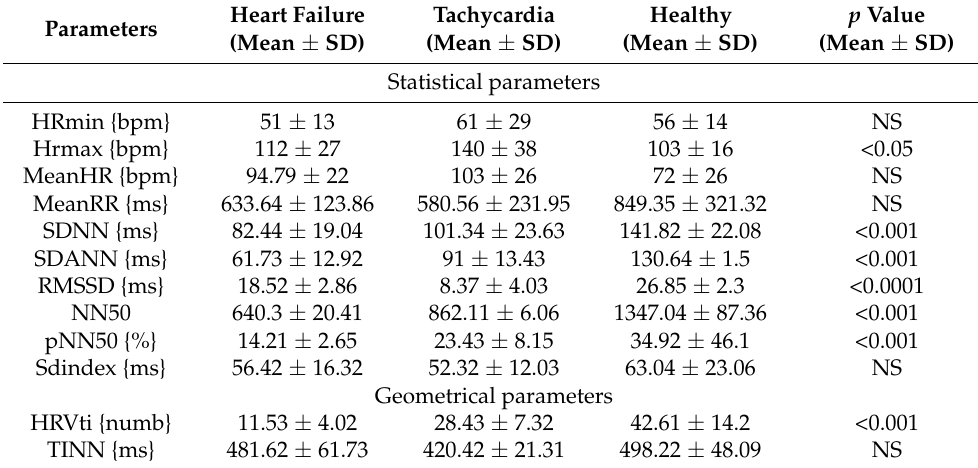
Table 4. Parameters in the time domain of the studied records. Parameters